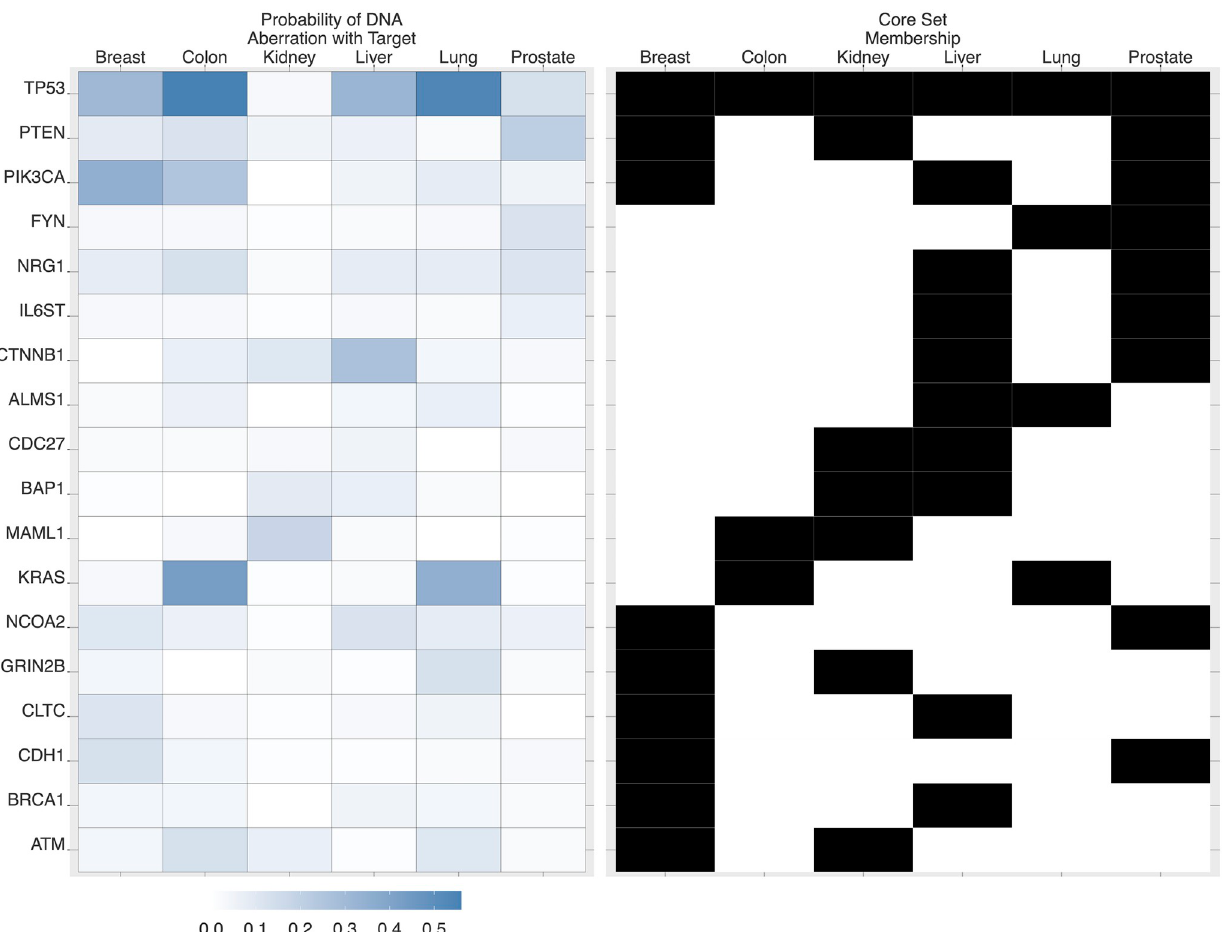
Fig 3. Core set across tissues at source level. There are 18 source genes which appear in the core set of at least two tissues. For instance, gene TP53 is a core gene for all six tissues, and genes PTEN and PIK3CA are core genes for three tissues. The color in the heatmap on the left represents the probability that the corresponding source gene is DNA-aberrant and there exists an RNA-aberrant target gene (thereby forming an aberrant source-target pair) . On the right, black marks indicate the membership of each gene to the corresponding core set for each tumor type.